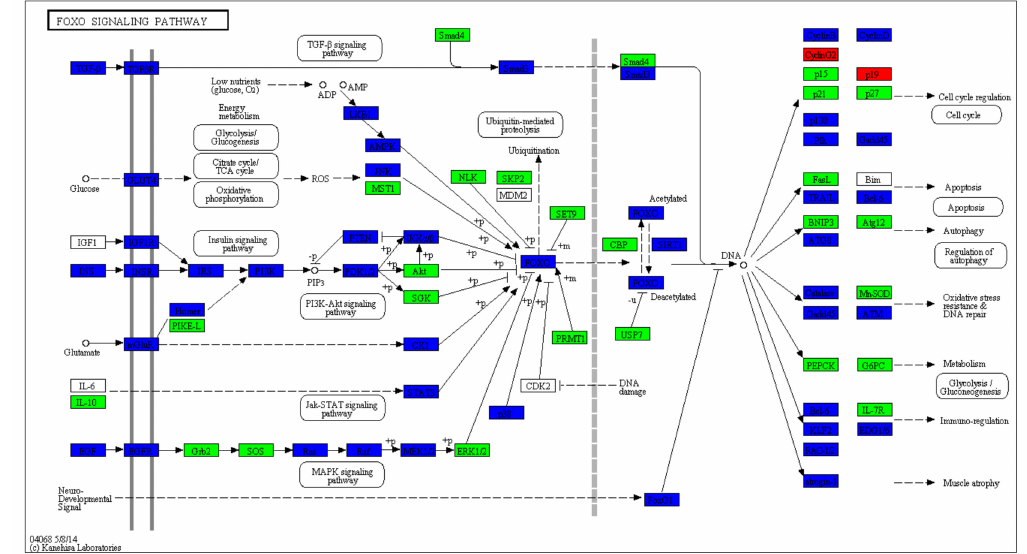
Figure 5. Annotated diagram of the Kyoto Encyclopedia of Genes and Genomes (KEGG) pathway analysis of di ff erentially expressed miRNA target genes. The green-box-labelled enzymes indicate a downregulation of a miRNA target gene, and the blue-box-labelled enzymes indicate an upregulation of a miRNA target gene compared with the normal expression of the target